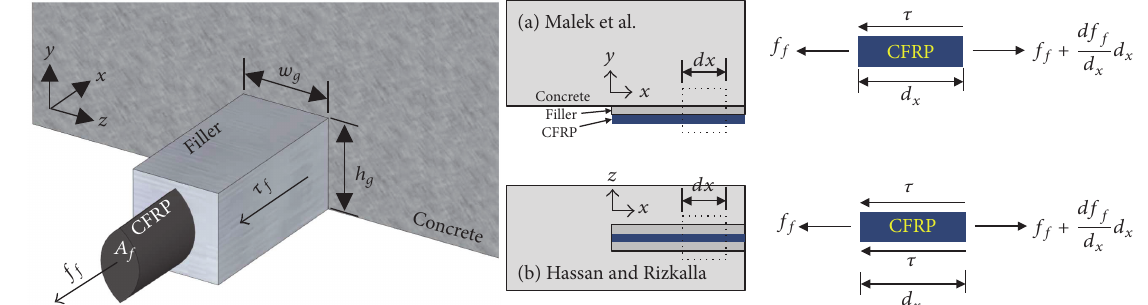
Figure 3: Shear stress developed at the interface [5,